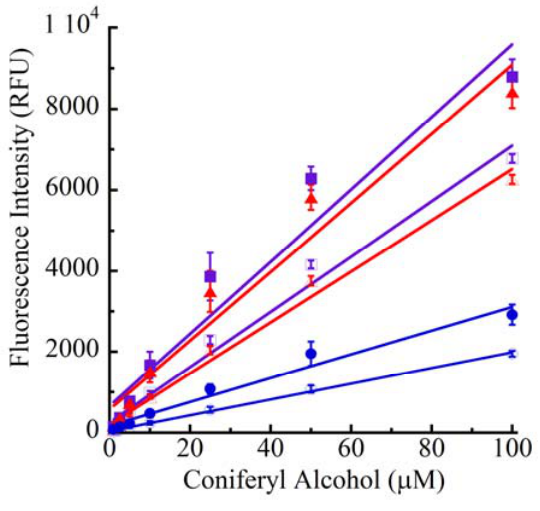
Figure 10B. Linearity of CA Dose-Response. All conditions are described in Figure 10A. The r 2 values were: 0.984 (  ex = 290 nm, 25  L; open squares, purple); 0.945 (  ex = 290 nm, 50  L; closed squares, purple); 0.989 (  ex = 310 nm, 25  L; open triangles, red); 0.958 (  ex = 310 nm, 50  L; closed triangles, red); 0.997 (  ex = 340 nm, 25  L; open circles, blue) and 0.973 (  ex = 340 nm, 50  L; closed circles,